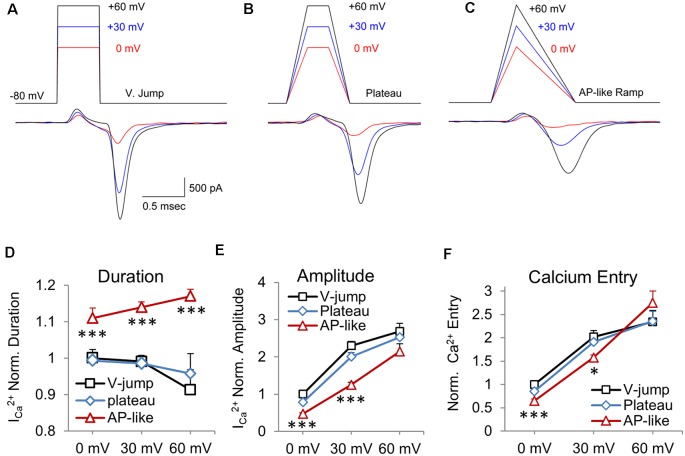
Area-matched stimuli demonstrate how the shape of the stimulus affects the presynaptic CaV2 channel response. Test pulses started at a holding potential of −80 mV and were depolarized to peak voltage values of 0 (red), +30 (blue), and +60 mV (black) and were constructed to have an equivalent area over a given peak voltage. The resulting calcium current appears below each pulse. (A) Voltage-jump stimuli maintained for 0.5 ms, with peak amplitudes of 0, 30 and 60 mV, followed by a return to holding potential of −80 mV. (B) Plateau wave stimuli, with matching stimulus areas to stimuli from panel (A), consisting of a 0.25 ms depolarization to 0, +30, or +60 mV for 0.25 ms, followed by a 0.25 ms repolarization to baseline. (C) Ramped AP-like stimulus: 0.3 ms ramped depolarization and a 0.7 ms ramped repolarization. (D–F) Data is presented as the average of the presynaptic recordings (n = 5 cells). These are cells where all three stimuli were tested at the three different peak amplitudes for nine separate stimuli. (D) Normalized duration of the CaV2 response. The average value of the response to the voltage-jump stimulus was normalized to one. This average value was used to normalize the average responses to the AP-like and plateau stimuli. Differences in AP-like and V-jump stimulation at 0, 30 and 60 mV are statistically significant (P < 0.005). (E) Normalized peak amplitude of the CaV2 response corresponding to each of the test waveforms. Differences between AP-like and V-jump stimuli at 0 and 30 mV were statistically significant (P < 0.005). (F) Normalized calcium current integral (nA*ms) for the response to each stimulus. Differences between the AP-like and V-jump stimuli were statistically significant for the 0 mV values (P < 0.005) and the 30 mV values (P < 0.05). *p < 0.05; ***p < 0.005.